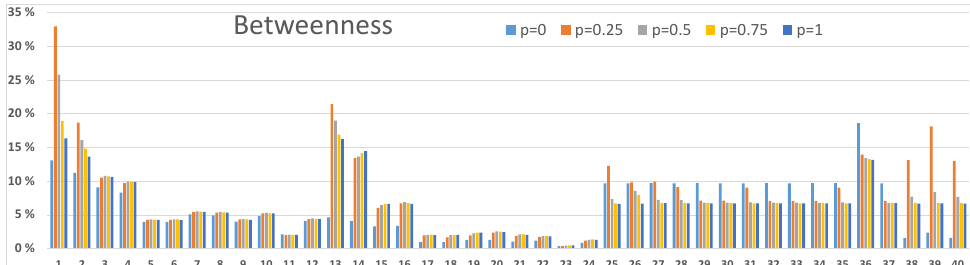
Figure 6. Betweenness values of nodes in the network structure of Figure 1. Connections ab, ac, bc, ad, bd and cd between networks are functioning with resilience values p = 0,0.25,0.5,0.75 and 1. The results correspond to Figure 3A.